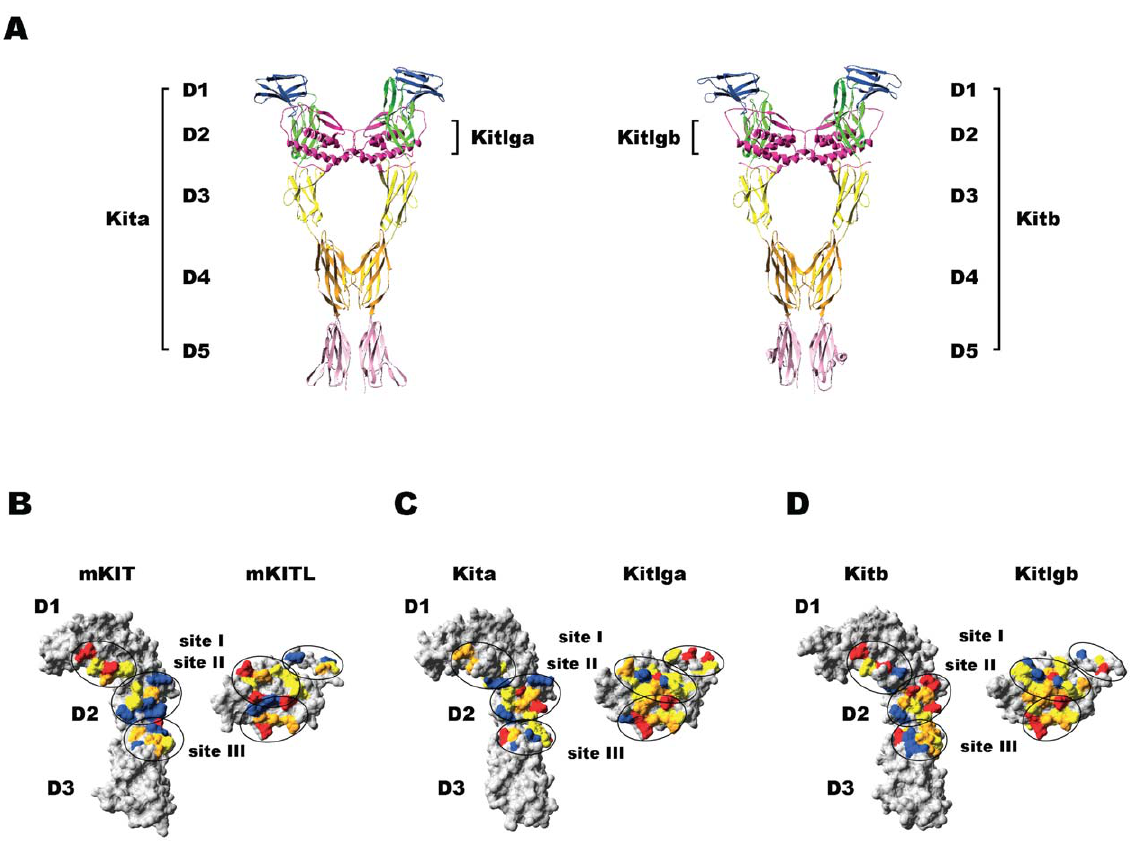
Figure 11. Molecular modeling of the three-dimensional structures of zebrafish Kit ligands (Kitlga and Kitlgb) and receptors (Kita and Kitb). (A) Ribbon model of the Kitlga-Kita (left) and Kitlgb-Kitb (right) complexes. The motif D1 is colored in blue, D2 in green, D3 in yellow, D4 in orange, and D5 in pink. Kit ligands are colored in magenta. (B–D) Surface models of the interphase of the mouse KITL-KIT (B), zebrafish Kitlga-Kita (C) and Kitlgb-Kitb (D) complexes. The Kit receptor part involving D1, D2 and D3 is shown on the left and the ligand part is on the right. The amino acids with negative charge, positive charge, polar and hydrophobic side chains are shown in red, blue, orange and yellow, respectively. The ligand-receptor binding sites (site I, site II, and site III) are circled.